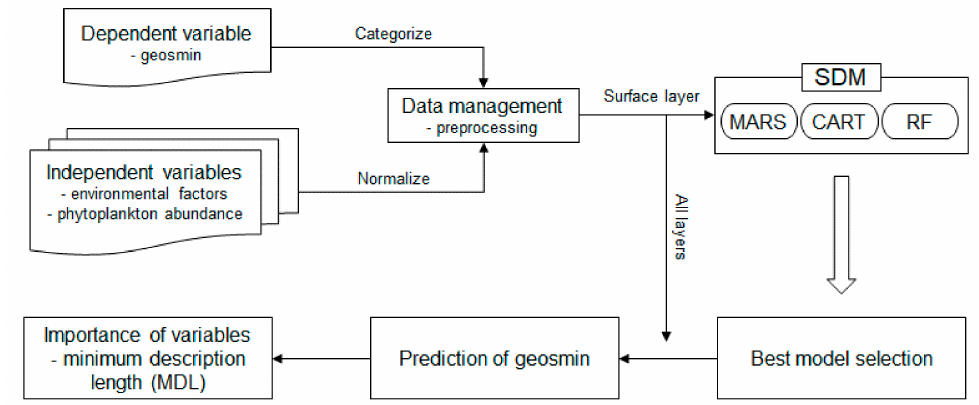
Figure 2. Flow chart of the modeling procedures to predict geosmin concentration categories based on phytoplankton abundance and environmental